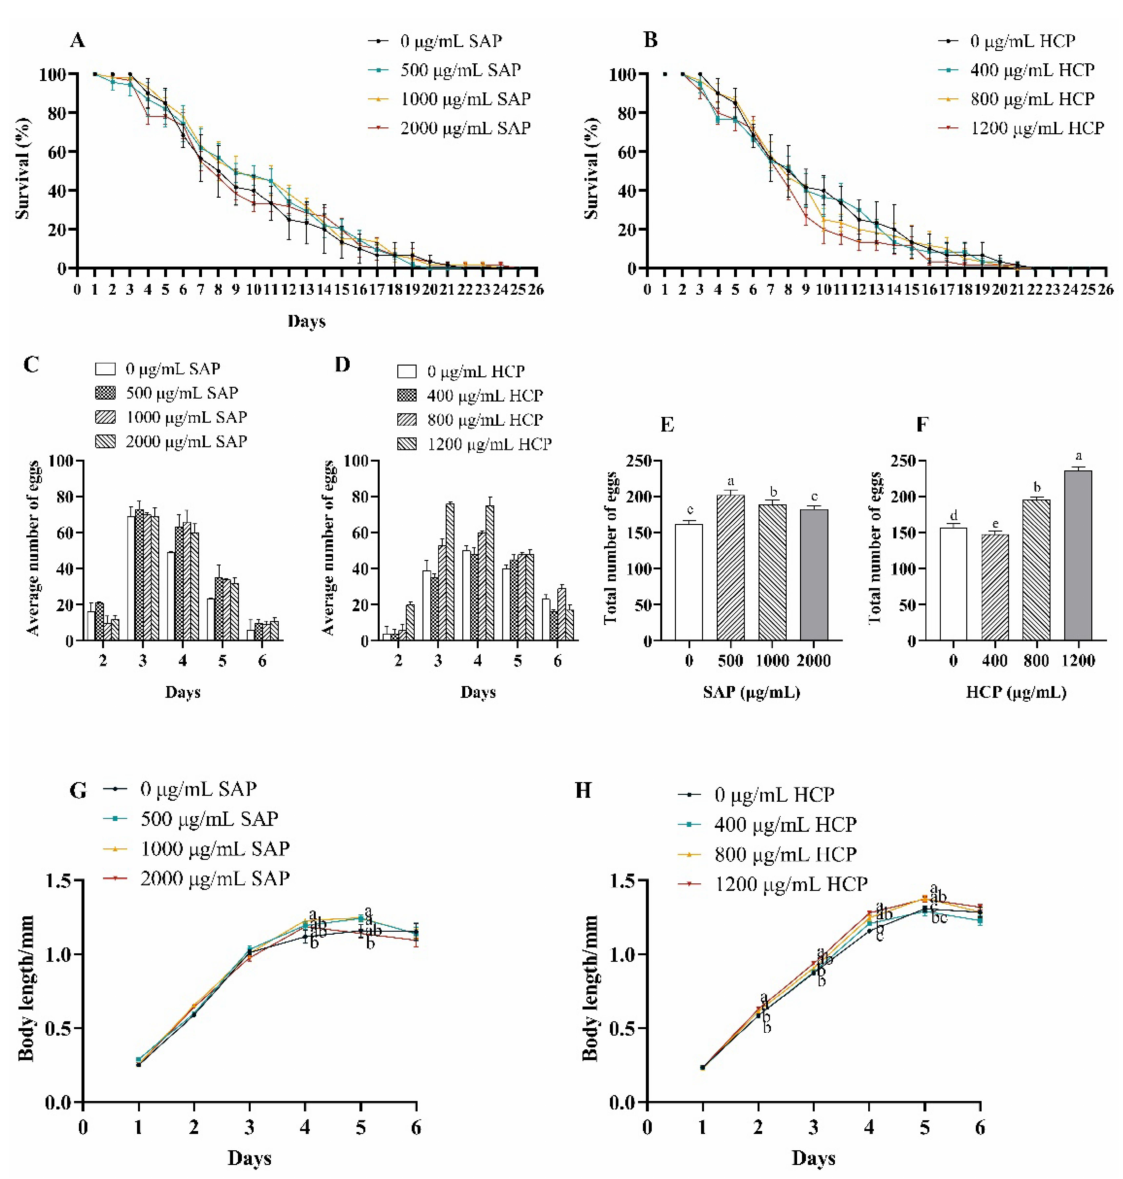
Figure 3. Effects of SAP and HCP on lifespan, reproduction, and body length of the C. elegans . ( A , B ): effects of SAP ( A ) and HCP ( B ) on the lifespan of C. elegans . ( C , D ): effects of SAP ( C ) and HCP ( D ) on the number of eggs of C. elegans on each day. ( E , F ): effects of SAP ( E ) and HCP ( F ) on the total number of eggs of C. elegans in the entire spawning period. ( G , H ): effects of SAP ( G ) and HCP ( H ) on the body length of C. elegans . Data are presented as mean ± SEM (n = 30). Values without a common letter are significantly different at p <